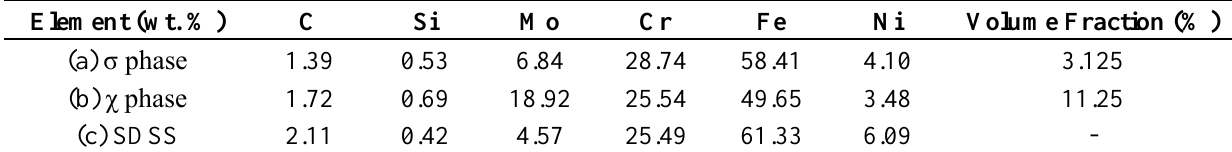
Table 2. Chemical composition of σ, χ phase and super duplex stainless steels (SDSS) based on energy dispersive X-ray (EDX) analysis (five minutes of isothermal ageing case). Element (wt.